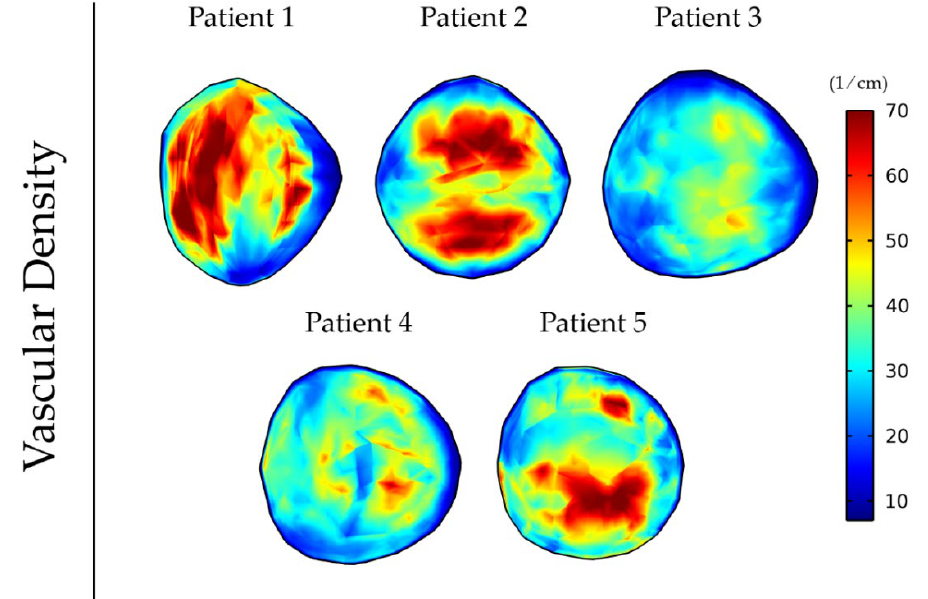
Figure 5. Vascular density at day 43 of the simulation for anisotropic tumor growth (A = 25) when incorporating the elastography data of the five patients.